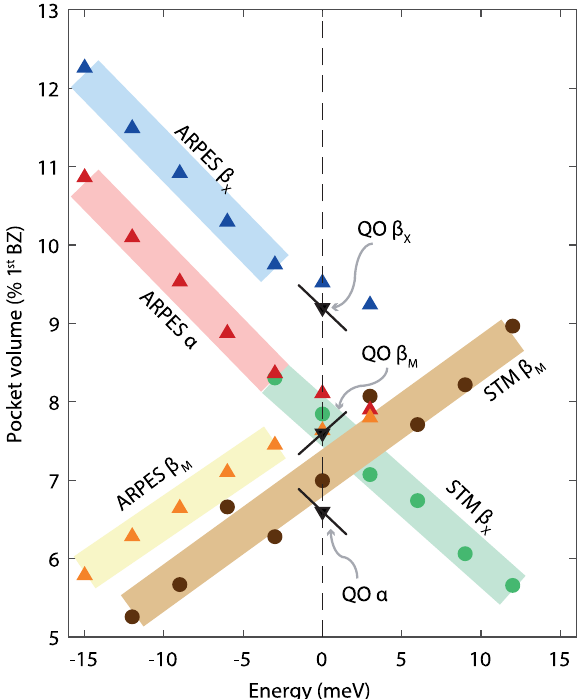
Fig. 4 Fermi surface pockets and effective masses. Extraction of effective masses from ARPES, STM, and QO. The data points show the volume d A FS ( ω ) of the different pockets as a function of energy (see also Supplementary Fig. 5). The effective masses are propor- tional to the slope of d A FS ( ω ). For the fi ts of the ARPES data, we excluded data points that are closer to the Fermi level than the energy resolution of the detector. The black lines and marks around the Fermi level indicate the masses and volumes extracted from